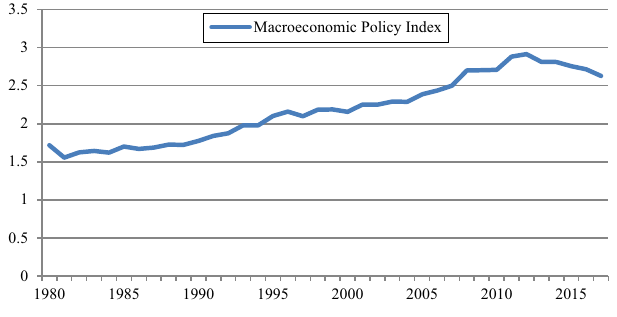
Figure 3. Time path of